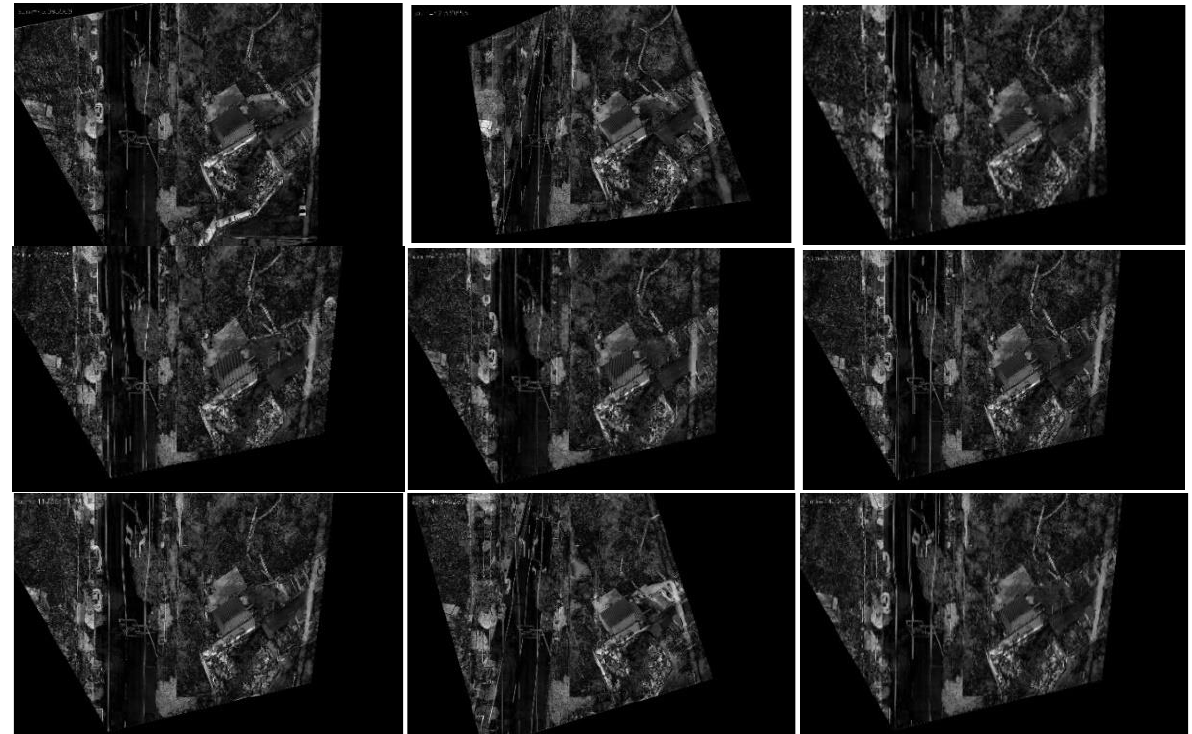
Figure 22. Registration difference image (without updating the map features).